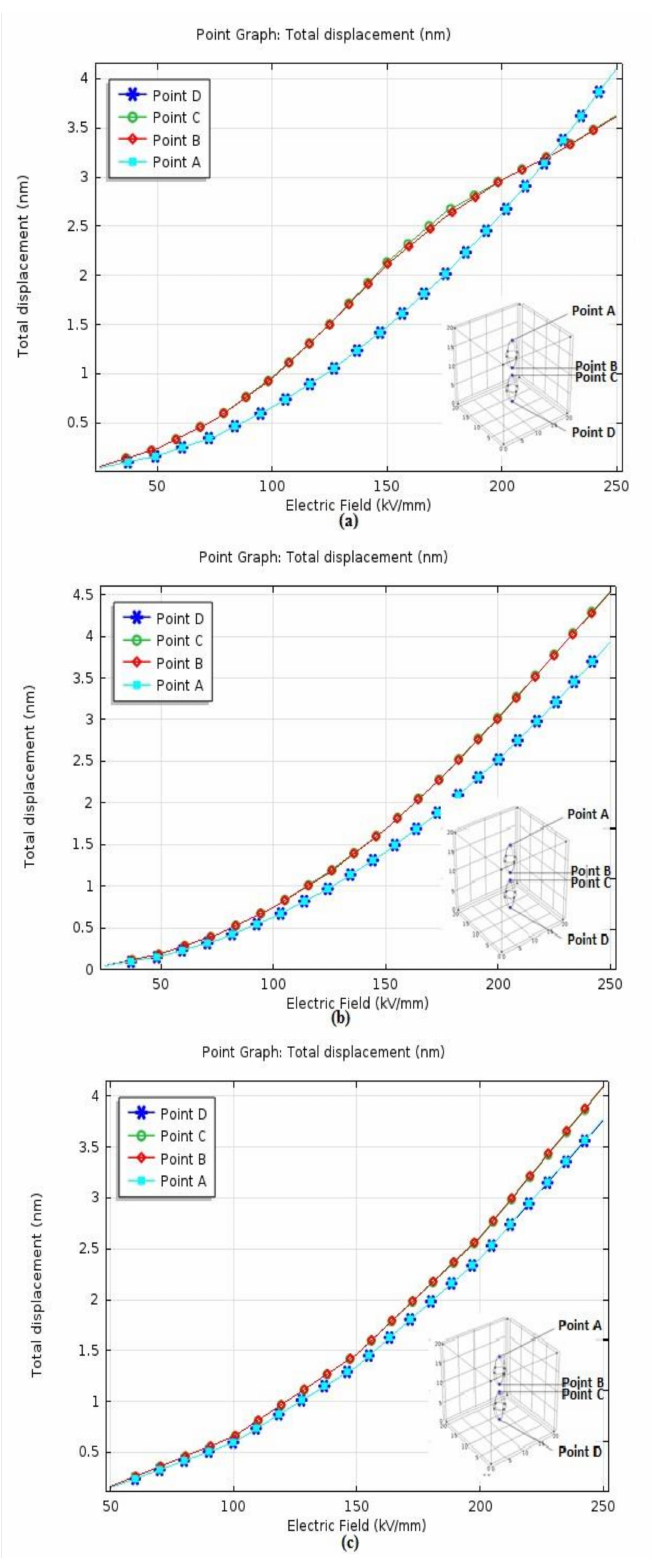
Figure 16. Total displacement of the tips of ellipsoids with increasing electric field (50–250 kV / mm) and decreasing distance between points B and C: ( a ) distance: 0.5 µ m; ( b ) distance: 1 µ m; ( c ) distance: 2 µ